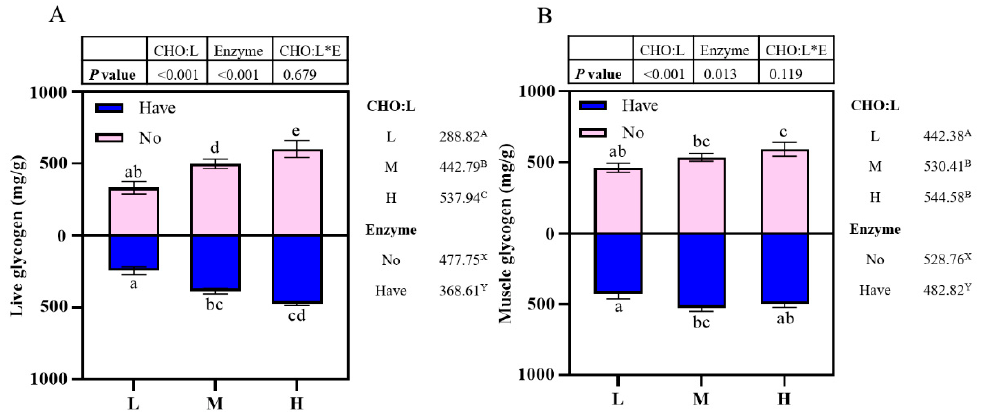
Figure 1. Effects of carbohydrase supplementation on glycogen content in hybrid grouper fed different CHO:L ratios diets (Figure 1A = Liver glycogen; Figure 1B = Muscle glycogen). Data represent means of three fish in each group; error bar indicates S. D. Average of different superscripts in the same column (a, b, c, d, e, etc. Or A, B, C, etc. Or X, Y) are significantly different ( p < 0.05). (Dietary CHO:L ratio = A, B, C, etc.; Dietary carbohydrase = X, Y); no means no enzyme, have means